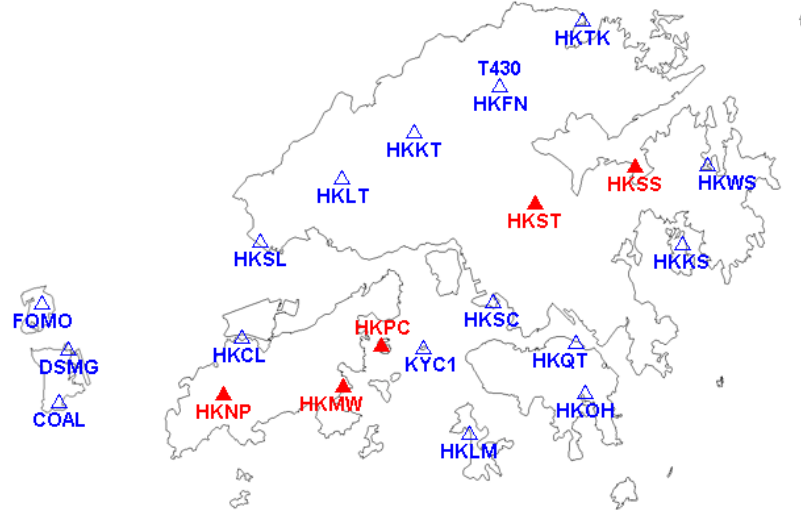
Figure 6. Distribution of Hong Kong Base Stations.